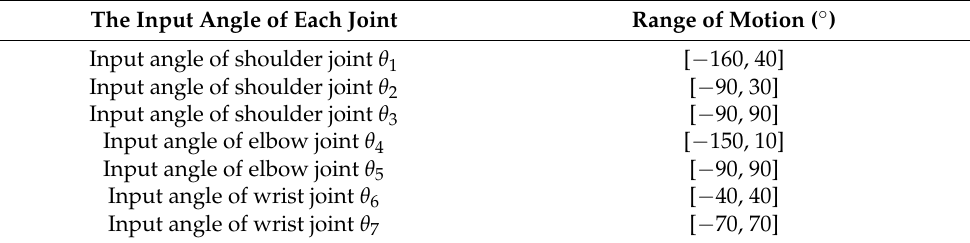
Table A2. The input angle range of each joint of the humanoid